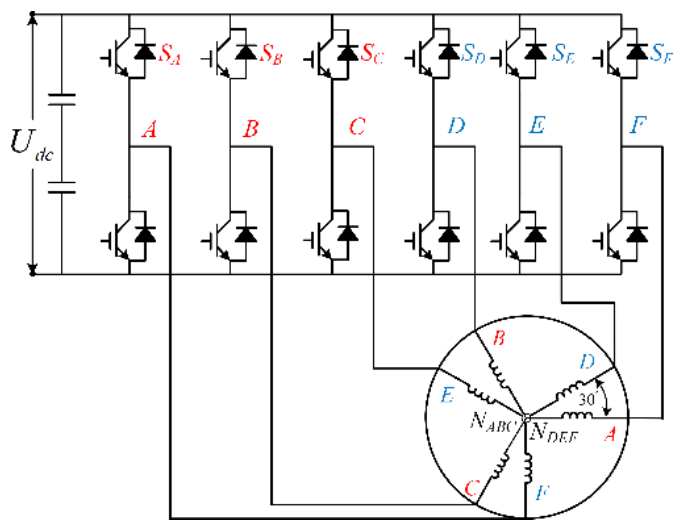
Figure 5. Six − phase inverter connected to DTP − SynRM. Figure 5. Six–phase inverter connected to